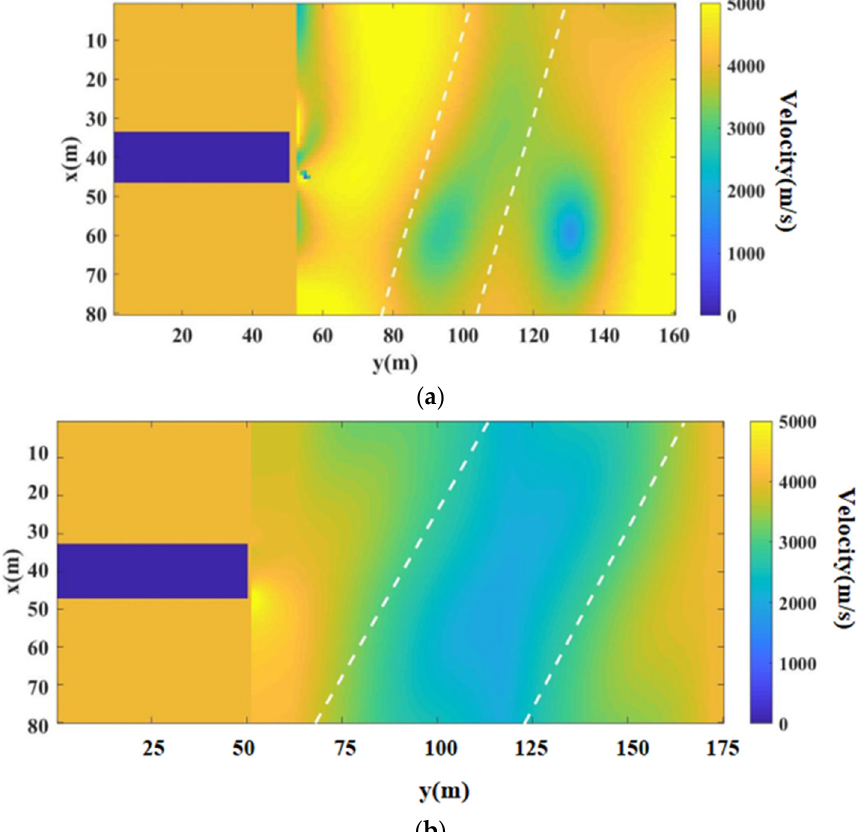
Figure 9. ( a ) FWI result of 30 m thick fault rock wave velocity numerical model. ( b ) FWI result of 110 m thick fault rock wave velocity numerical model.